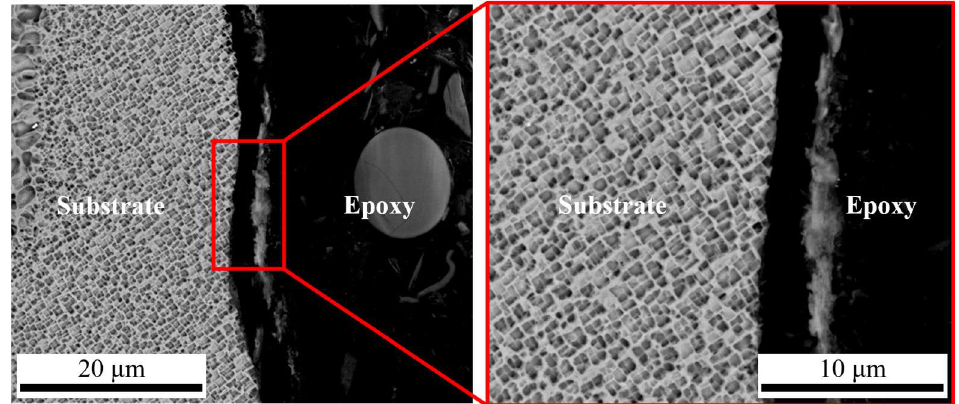
Figure 12. SEM images of CWALSM at optimum parameters level.